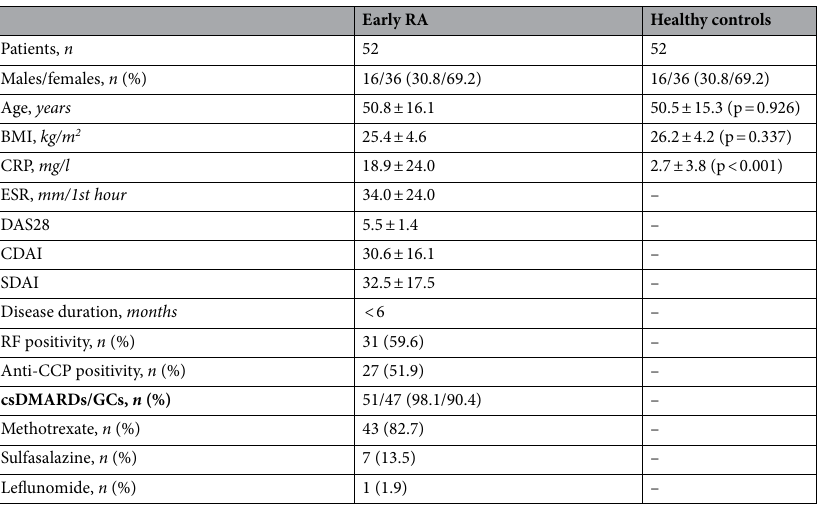
Table 1. Baseline characteristics of early RA patients and healthy controls. Anti-CCP anti-cyclic citrullinated peptide antibodies, BMI body mass index, CDAI Clinical Disease Activity Index, CRP C-reactive protein, csDMARDs conventional synthetic disease-modifying antirheumatic drugs, DAS28 28-joint Disease Activity Score, ESR erythrocyte sedimentation rate, GCs glucocorticoids, RA rheumatoid arthritis, RF rheumatoid factor, SDAI Simplified Disease Activity Index. Data are presented as the mean ± the